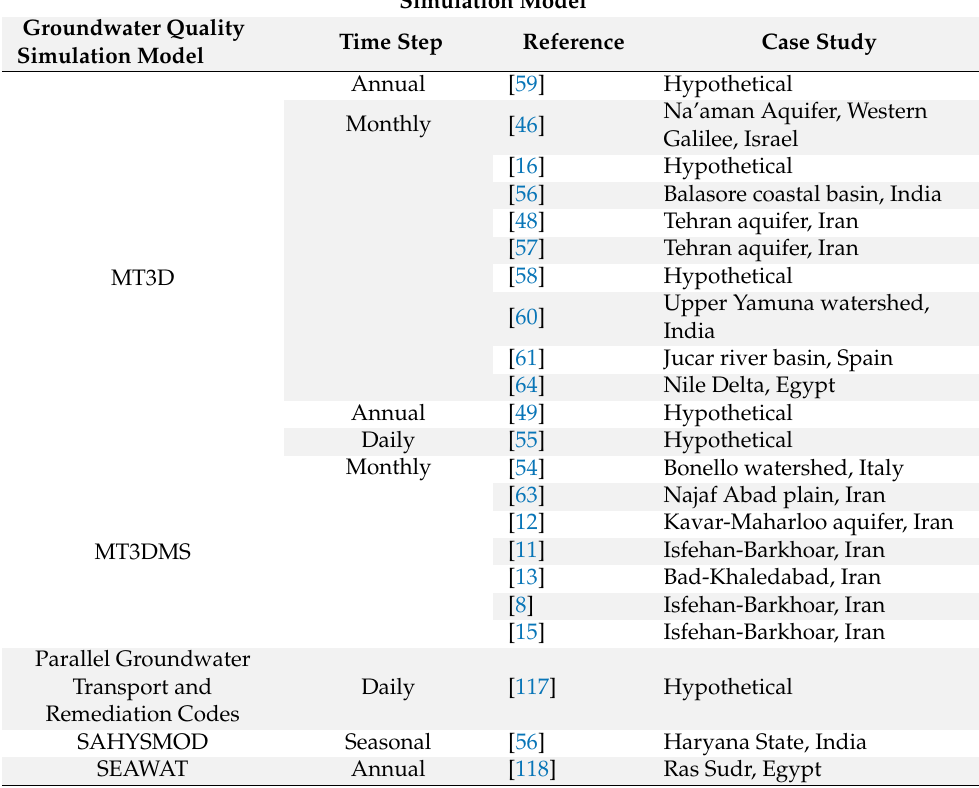
Table 3. Classification of different qualitative simulation groundwater